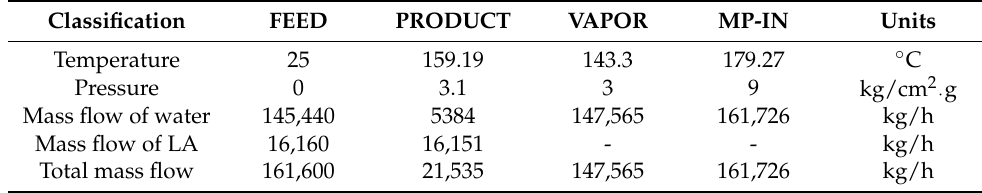
Table 4. Simulation results for conventional process.